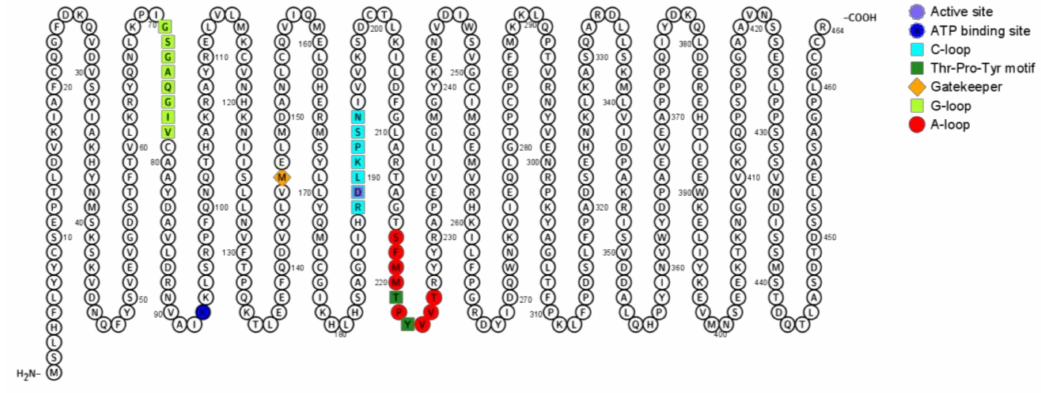
Figure 3. Two-dimensional structure of JNK3. Key structure elements are colored as shown in legend. Figure generated with